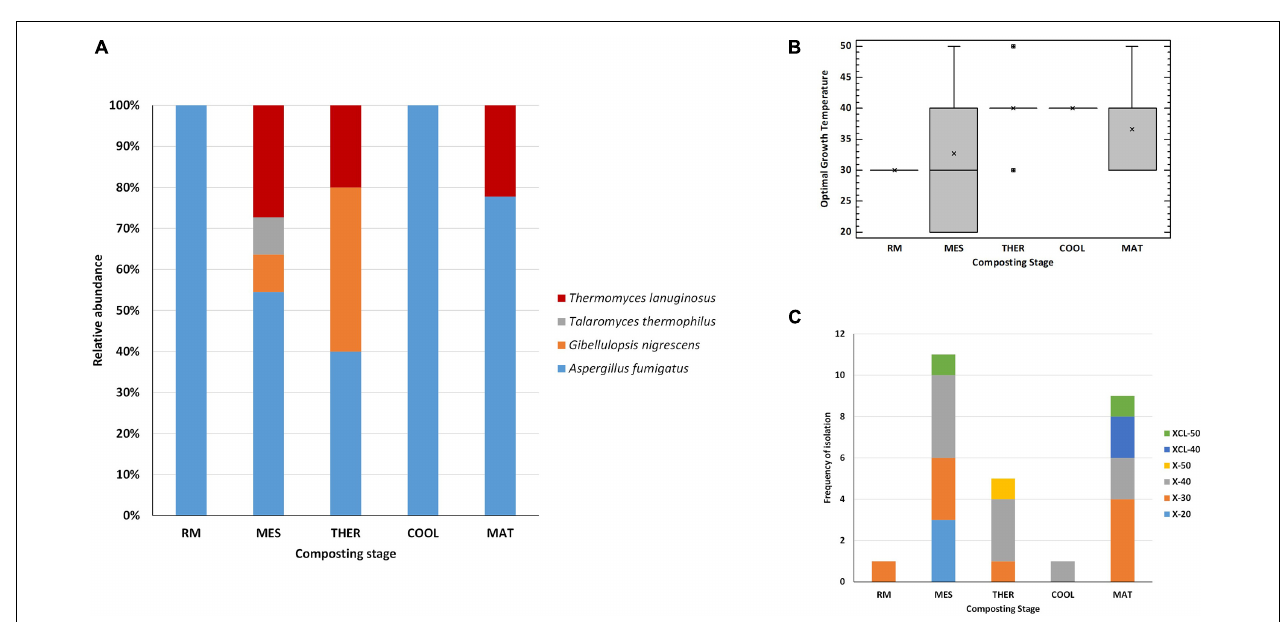
FIGURE 4 | Optimal growth temperatures of the thermophilic fungi isolated from compost. (A) Box-and-whisker plot summarizing the range of optimal growth temperature for the different strains of each species; mean values (x), median (I), and outliers ( (cid:3) ) are represented; (B) relative abundance of strains for each species having the optimal growth temperature and enzyme activity: xylanolytic strains with optimal growth at 20 ◦ C (X-20), 30 ◦ C (X-30), 40 ◦ C (X-40), and 50 ◦ C (X-50), and xylanolytic-cellulolytic-ligninolytic strains with optimal growth at 40 ◦ C (XCL-40) and 50 ◦ C (XCL-50).